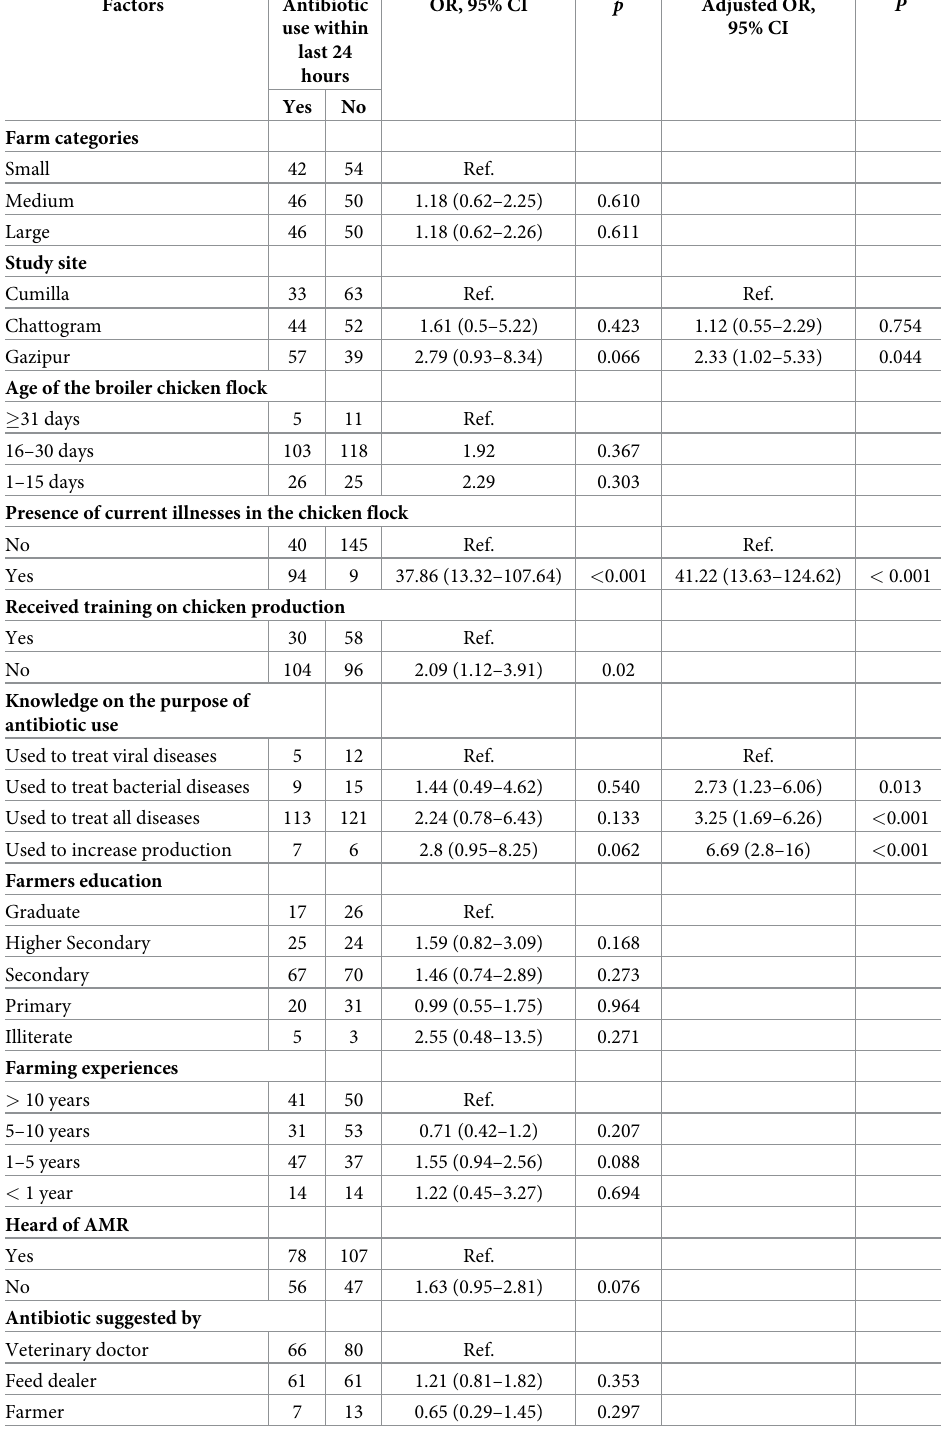
Table 8. Factors associated with antibiotic use in commercial broiler farms (N = 288), during January-May 2021,